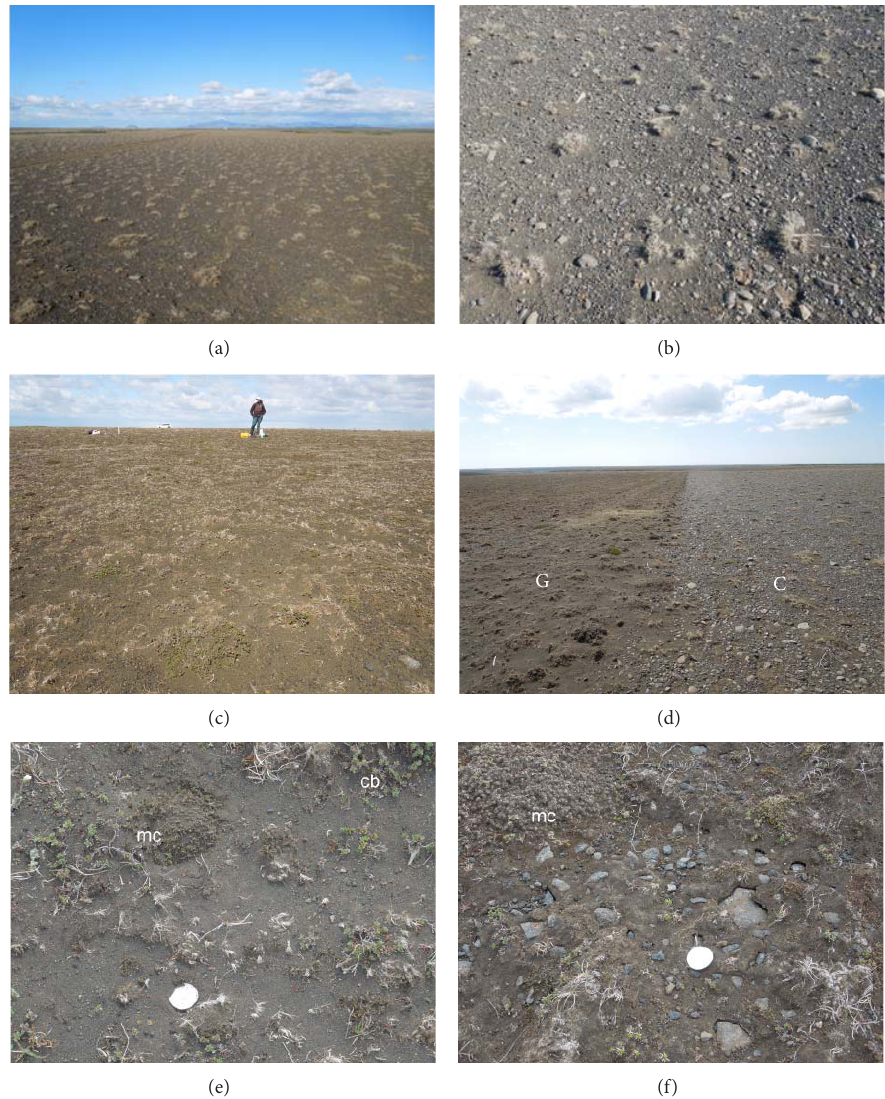
Figure 2: Views of control and grass-seeded plots. (a) Typical control plot exhibiting a gravelly surface with isolated tufts of grasses. (b) Detail of (a). Gravel-free haloes of sand surrounding grass tufts are aeolian deposits. (c) Typical view of grass-seeded plot. Surface is ca. 70% vegetated, with 50% grass and 20% nongrass (mostly crowberry). (d) Contrast between rocky, sparsely vegetated untreated surface (C) and the more heavily vegetated grass-seeded surface (G). The baffling effect of the vegetation is evidenced by the significant aeolian accumulation on the grass-seeded plots. (e) Detail of grass-seeded plot illustrating variety of native plants succeeding initial grass seeding and aeolian sediment veneer; mc = moss campion, cb = crowberry. (f) Detail of grass-seeded plot illustrating BSC covering entire surface that is not vegetation or